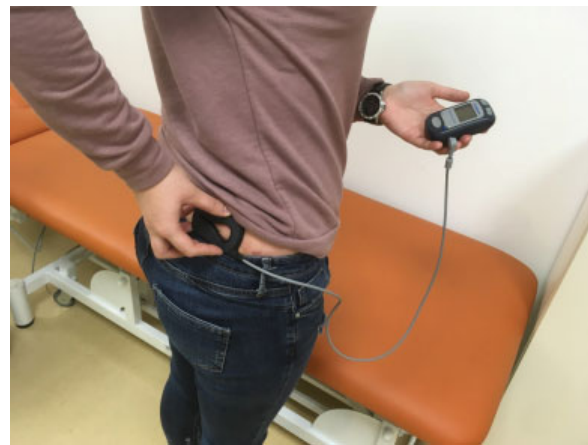
Fig. 3 Transcutaneous remote control of current intensity of the S3